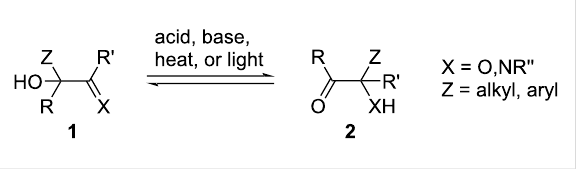
Figure 1: Generalized α -ketol or α -iminol